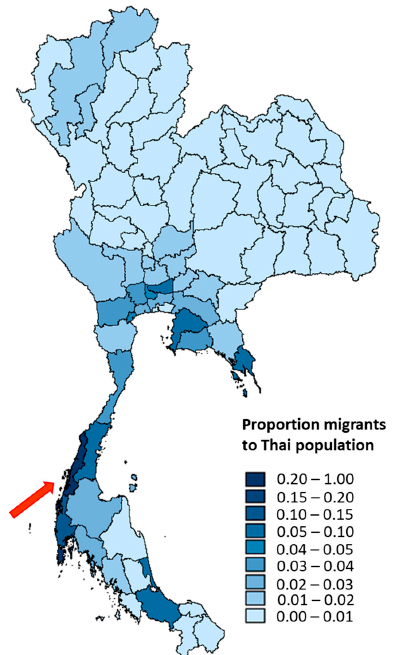
Figure 1. Ratio of registered migrants to Thai citizens in all provinces in Thailand.